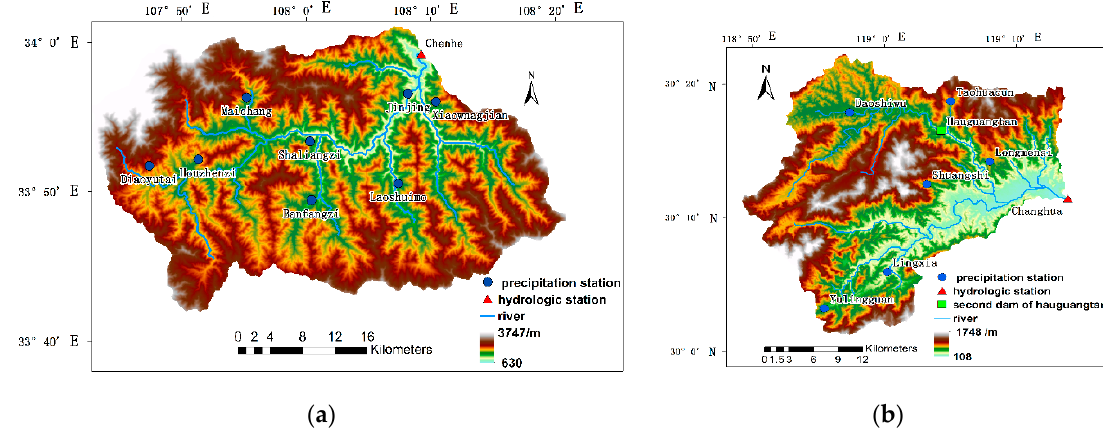
Figure 2. Digitial elevation model (DEM) and precipitation station: ( a ) Chenhe Watershed ( b ) Changhua Watershed.